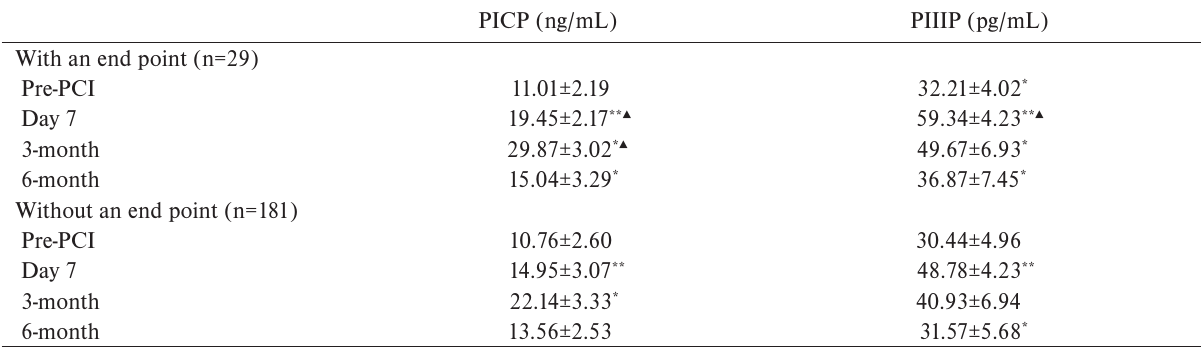
Table 2. Comparison of PICP and PIIINP between the two